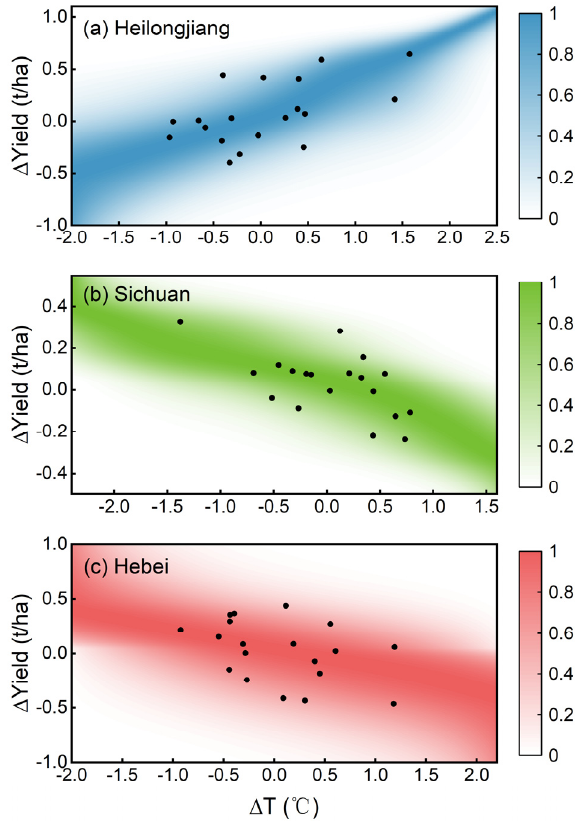
Figure 4. Joint distribution (normalized between 0 to 1) between detrended temperature ( ∆ T GS ) and yield ( ∆ Yield) during the reference period for ( a ) Heilongjiang province (rice), ( b ) Sichuan province (wheat), and ( c ) Hebei province (maize), respectively. The colored pixels on the z-axis in each panel represent the probability density function (PDF) at a given ∆ T GS - ∆ Yield pair, with 1 denoting the highest density and 0 denoting the lowest density. The black dots show the location of the observed ∆ Yield at different ∆ T GS .